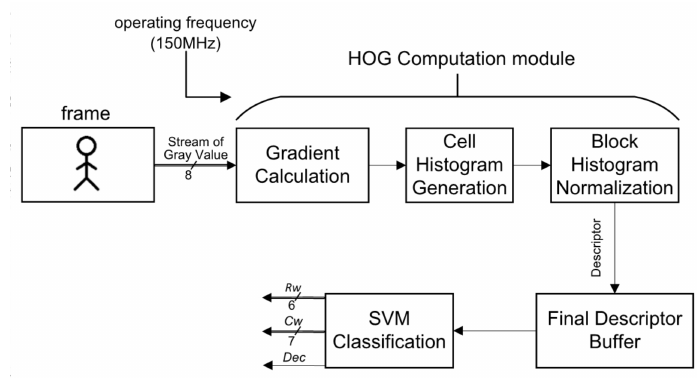
Figure 2. Flow of the proposed system’s pedestrian detection algorithm.